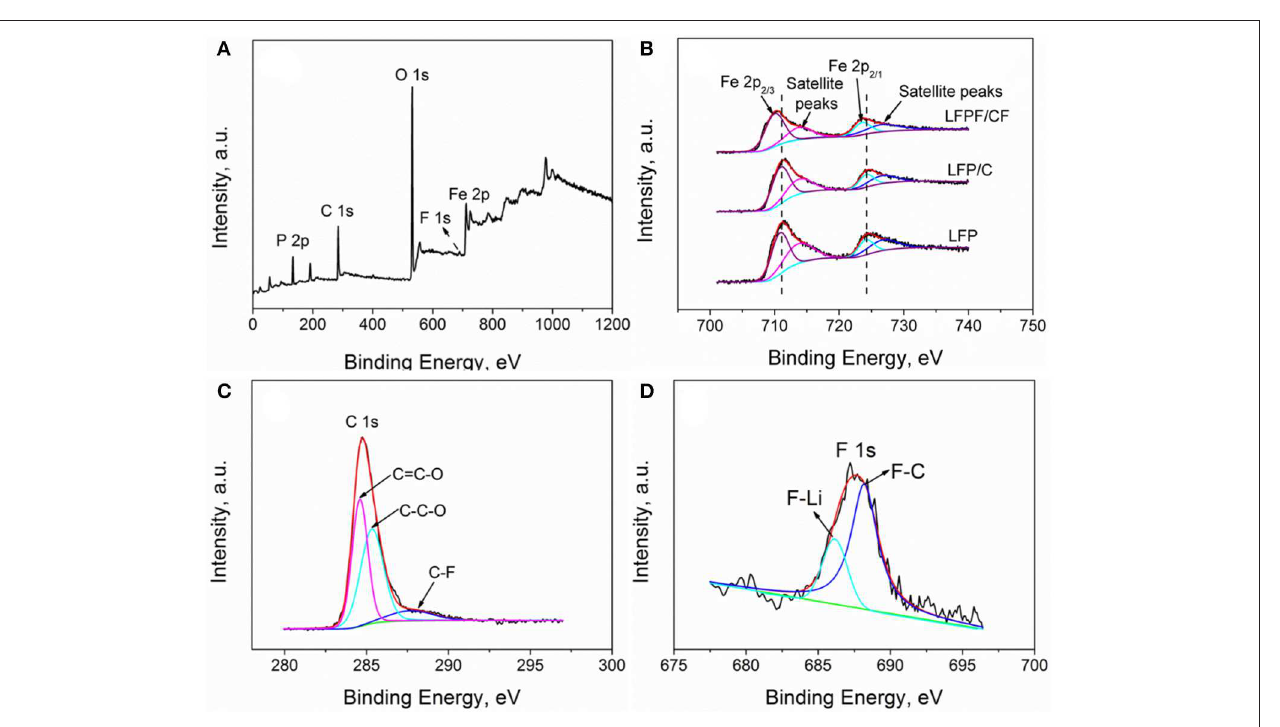
size of LFP/C are smaller than that of pure LFP, whereas thin carbon layer with the thickness of 2–5 nm on the surface of LFP particles were observed. Moreover, as shown in Figure 6C 1 , LFPF/CF shows smaller particles size than that of pure LFP, and there are F-doped carbon between LFP particles. HRTEM image of the LFP@CF ( Figure 6C 2 ) shows the F-doped carbon layer with 2–5 nm were coated on the